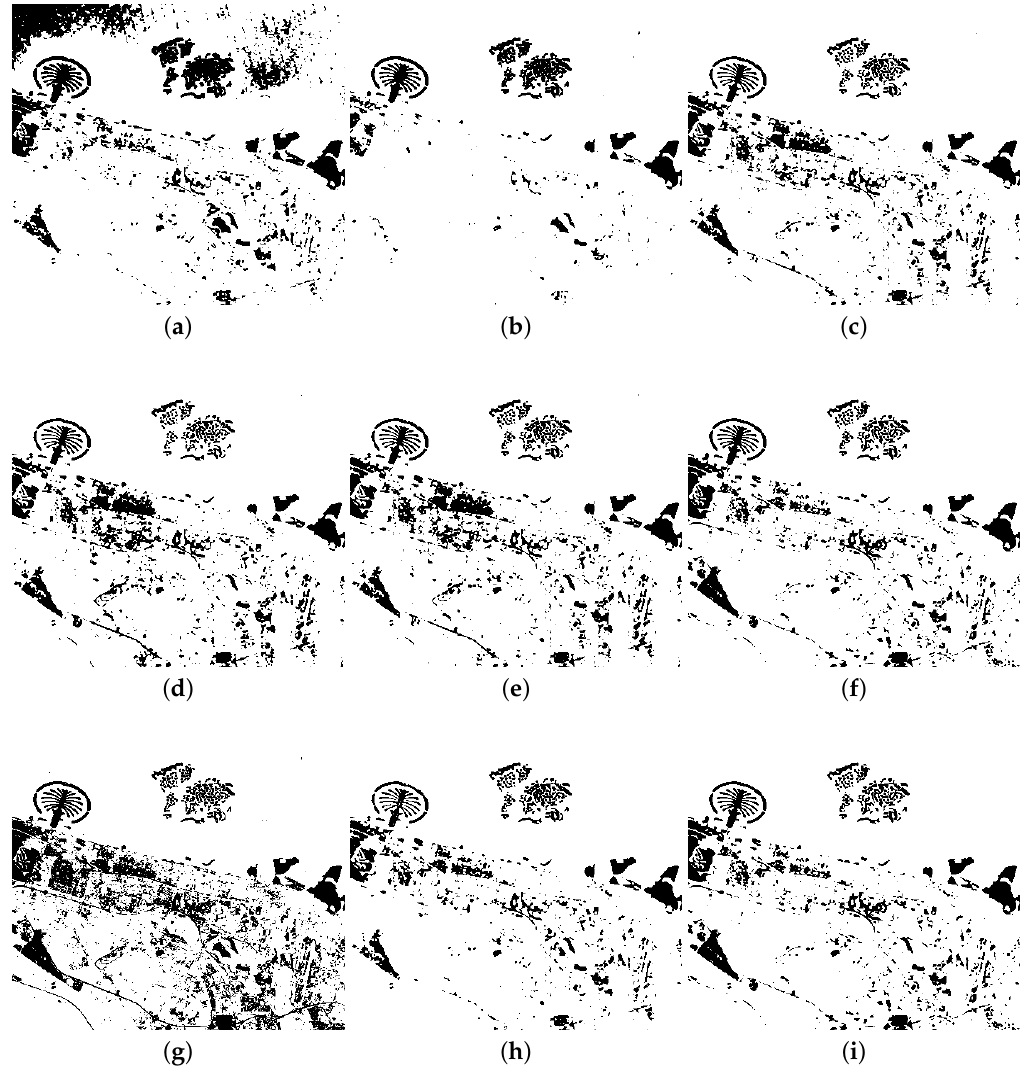
Figure 8. Change map of Dubai City dataset (band 1) by ( a ) Normalized DI+FCM ( b ) Ratio Image +FCM ( c ) Bandwise NSCT fusion +FCM ( d ) Bandwise NSCT fusion +SPSO ( e ) Bandwise NSCT fusion +PSOLF ( f ) Bandwise NSCT fusion +LIPSO ( g ) CVA ( h ) Transform CVA+LIPSO ( i ) Proposed NSCT feature fusion (All 4 bands)